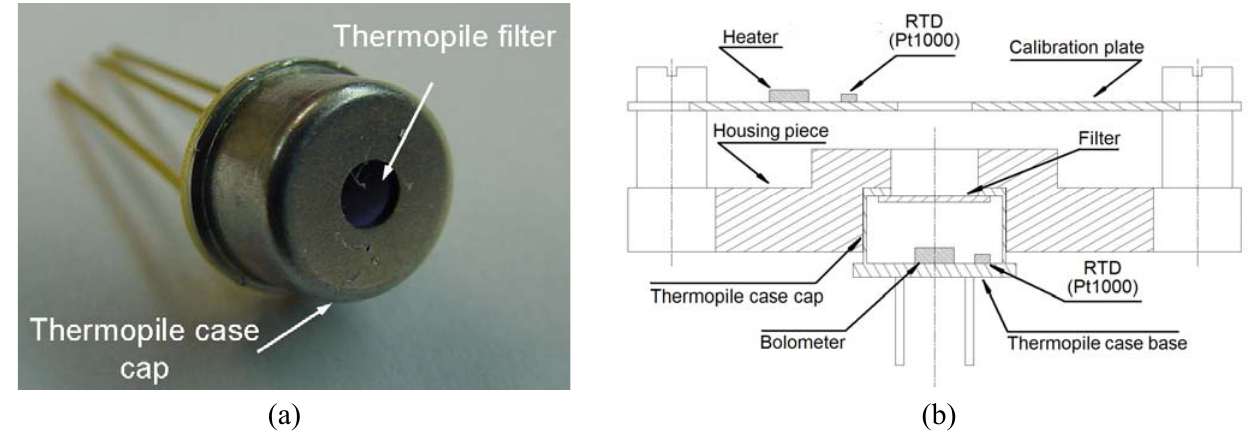
Figure 3. (a) A photograph of the IPHT TS-100 thermopile; (b) The 2D mechanical layout of REMS GTS and a